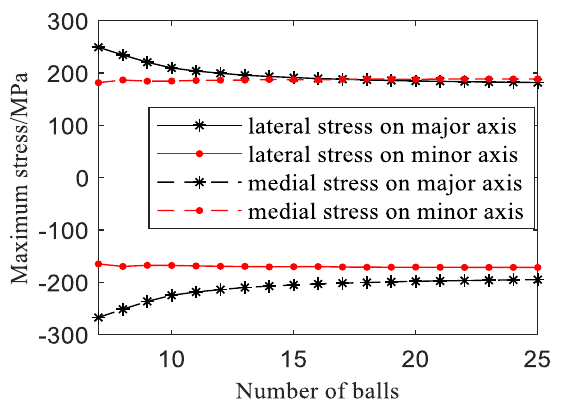
Fig. 14. The in fl uence of number of balls on the maximum bending normal stress.